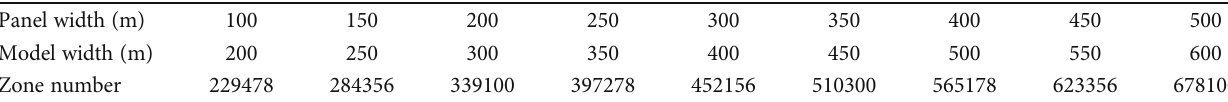
Table 4: Selection of di ff erent panel